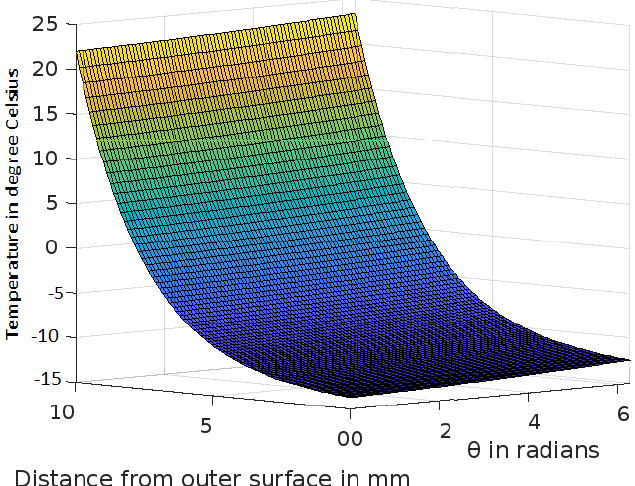
Figure 6. Variation of temperature profiles in human skin with an external temperature at the skin surface of − 15 ◦ C.